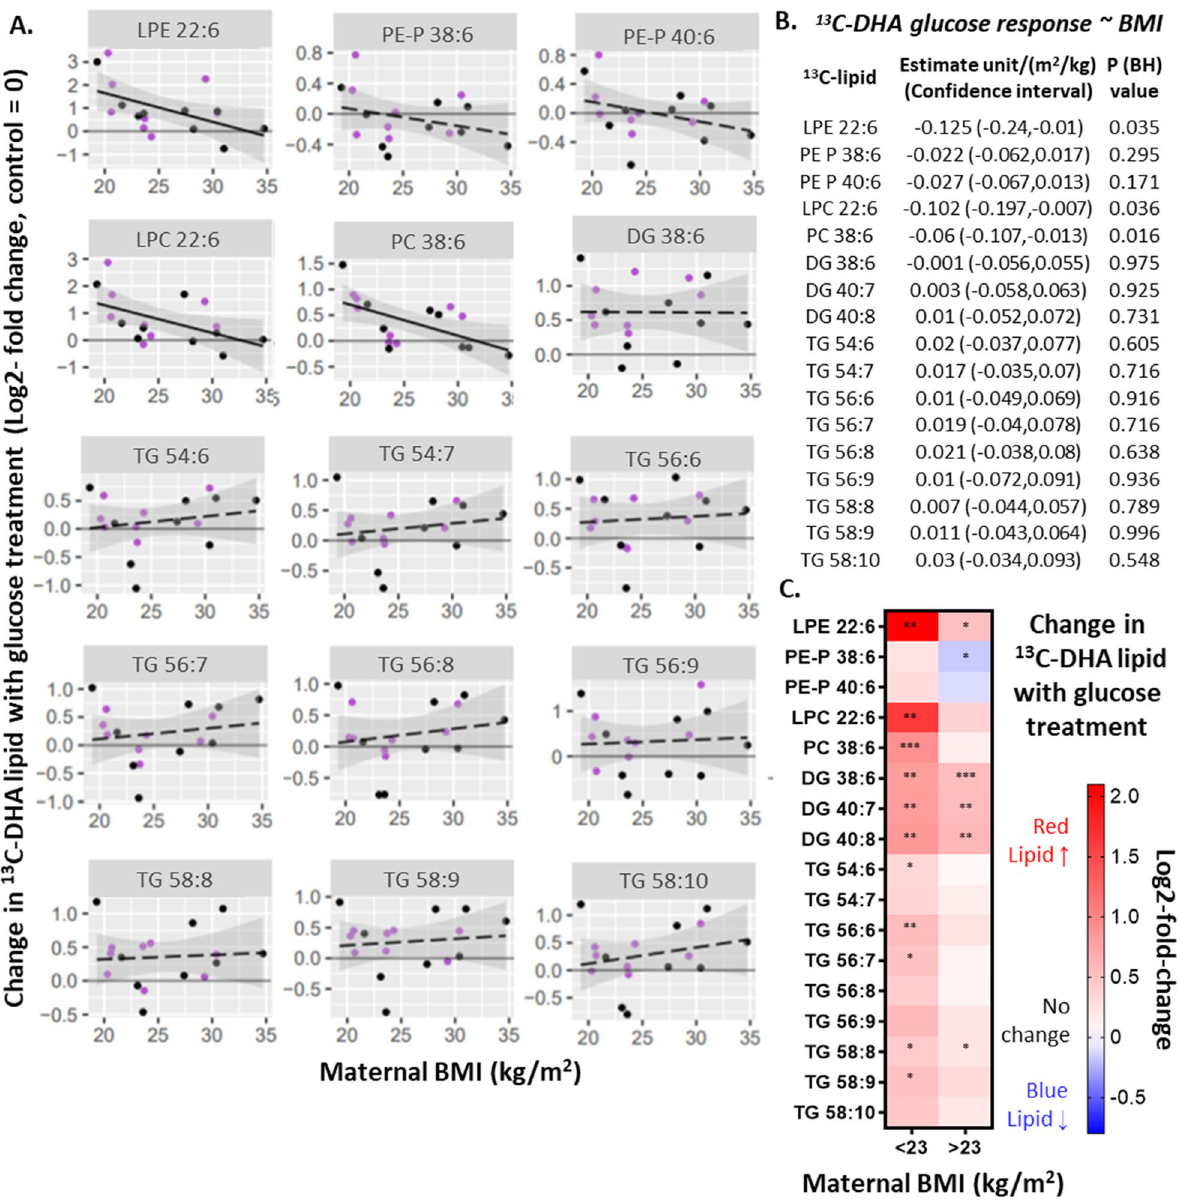
Fig. 5 Associations between maternal BMI and change in 13 C‑DHA lipids with glucose treatment (i.e. glucose response, log2‑fold change, n 17). = Change in 13 C‑DHA lipid with glucose treatment represents the relative amount of 13 C‑DHA lipid in placental explants treated with glucose (10 mmol/L) compared to control explants (cultured in 5 mmol/L glucose) from the same placenta. Positive values indicate an increase in 13 C‑DHA lipids compared to the control, whilst negative values indicate a decrease. A , B Linear regression was run with glucose response as the outcome and BMI as the exposure variable. Benjamini–Hochberg (BH) method was used to correct for multiple testing. Solid lines show statistically significant associations, while dashed lines show non‑significant results. Shaded areas show 95% confidence intervals. Key for dots—Purple: non‑GDM, Black: GDM. C Analyses stratified by maternal BMI. Heat map illustrating glucose response in placental explants from normal weight women (BMI < 23 kg/ m 2 ) and from overweight/obese women (BMI 23 kg/m 2 ). Colours indicate an increase (red; positive glucose response) or a decrease (blue; ≥ negative glucose response). Asterisks indicate significant differences between 10 mmol/L glucose treatment and the control (5 mmol/L) *p < 0.05, **p < 0.01, ***p < 0.001. Comparisons were made by repeated measures analysis of variance for each lipid followed by the Benjamini–Hochberg correction for multiplicity. BH Benjamini–Hochberg, CI confidence interval, DG diacylglycerol, DHA docosahexaenoic acid, GDM gestational diabetes, LPC lyso‑phosphatidylcholine, LPE lyso‑phosphatidylethanolamine, PC phosphatidylcholine, PE-P phosphatidylethanolamine‑plasmalogen, TG